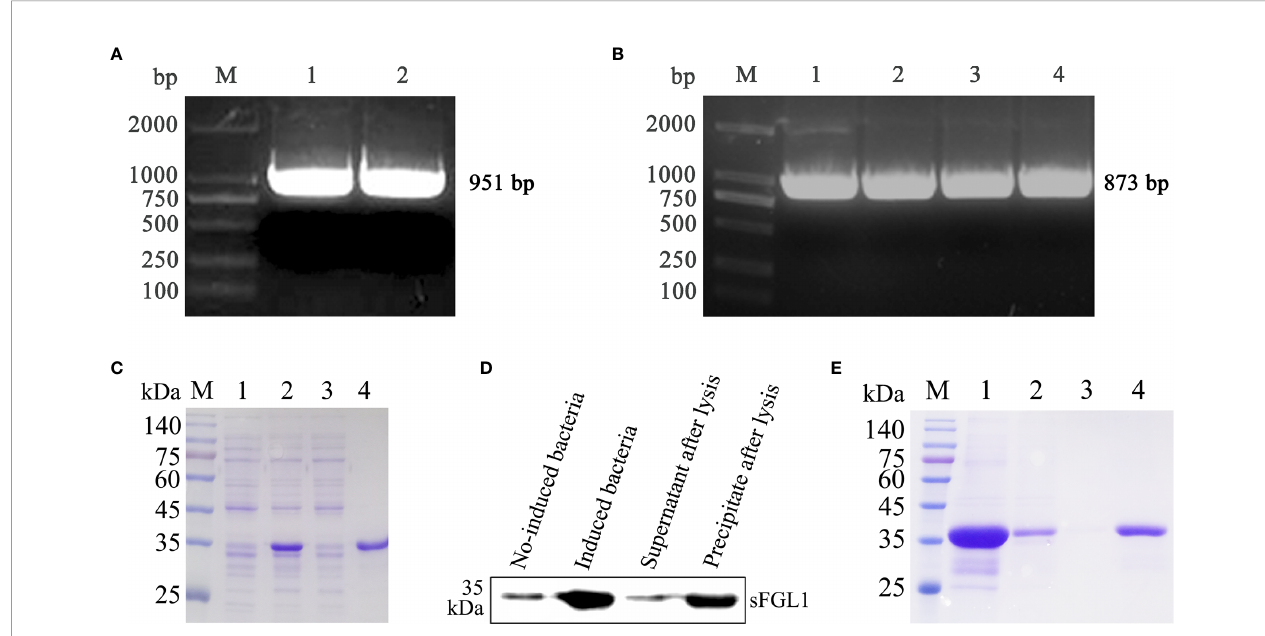
FIGURE 1 | Expression, identi fi cation, and puri fi cation of recombinant sFGL1. (A) Amplify full-length sFGL1 gene using RT-PCR method. M, DL2000 DNA marker; 1 – 2, Full-length sFGL1 gene. (B) Amplify sFGL1 gene without sequence encoding the signal peptide. M, DL2000 DNA marker; 1 – 4, sFGL1 gene without fragment encoding the signal peptide. (C) Identify sFGL1 expression by SDS-PAGE and Coomassie brilliant blue staining. M, Prestained protein marker(SMOBIO PM2500); 1, No-induced JM109-pQE30-sFGL1; 2, Induced JM109-pQE30-sFGL1; 3, Supernatant after lysis; 4, Precipitate after lysis. (D) Identify sFGL1 expression by Western blot. (E) Puri fi cation of sFGL1. M, Prestained protein marker(SMOBIO PM2500); 1, Sample loaded; 2, Ef fl uent; 3, 5 mmol/L imidazole eluent; 4, Puri fi ed